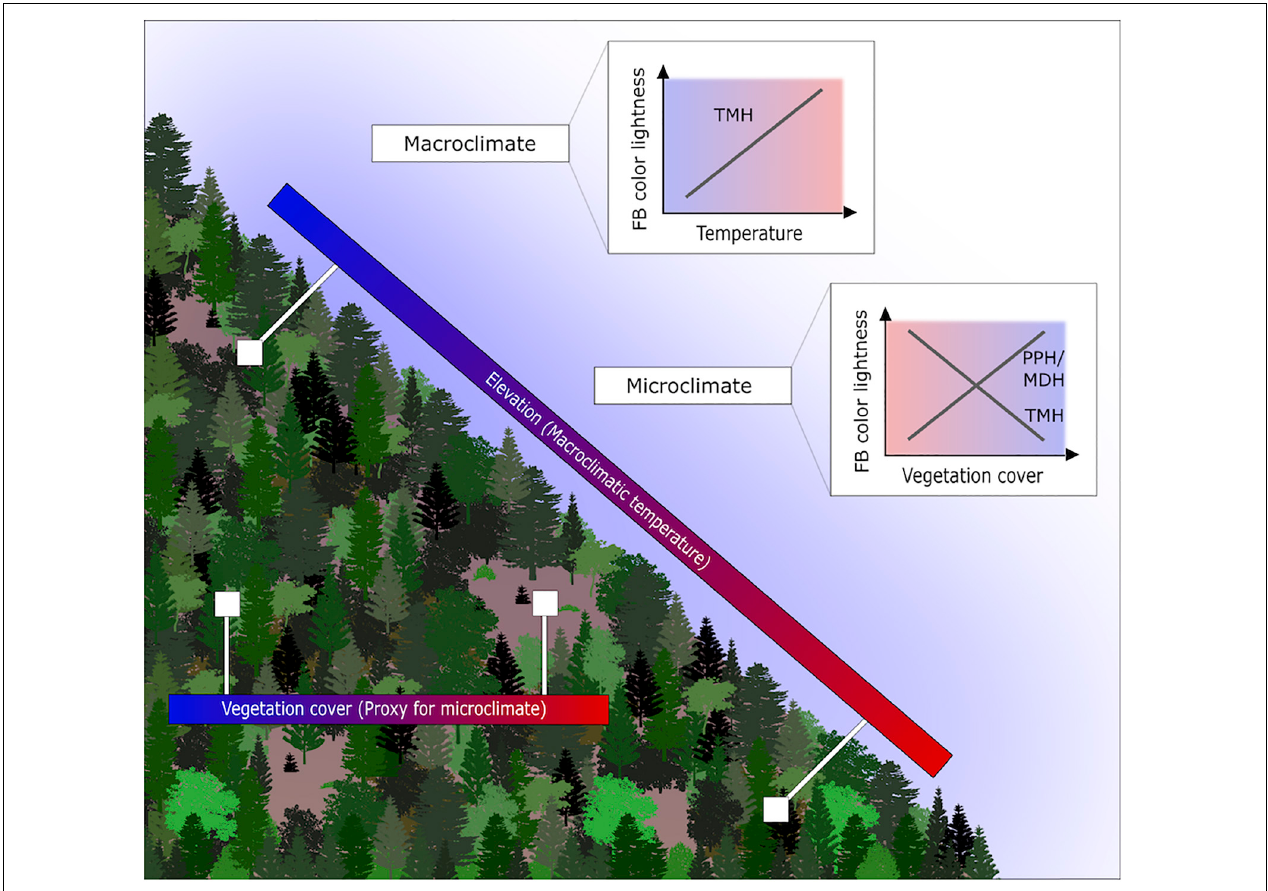
FIGURE 1 | Study setting, gradients and expected pattern of assemblage fruit body color lightness. Displayed are the elevational gradient reflecting the macroclimatic temperature gradient. Further, displayed is the closed and open vegetation cover, which we use as a proxy for the microclimate. We investigate whether the pattern of the assemblage fruit body color lightness follows predictions of the thermal-melanism hypothesis (TMH), which states darker pigmented individuals in colder environments. Alternative hypotheses for the microclimate include the photo-protection hypothesis (PPH; vegetation cover as a proxy for UV radiation) and the melanism-desiccation hypothesis (MDH; vegetation cover as a proxy for